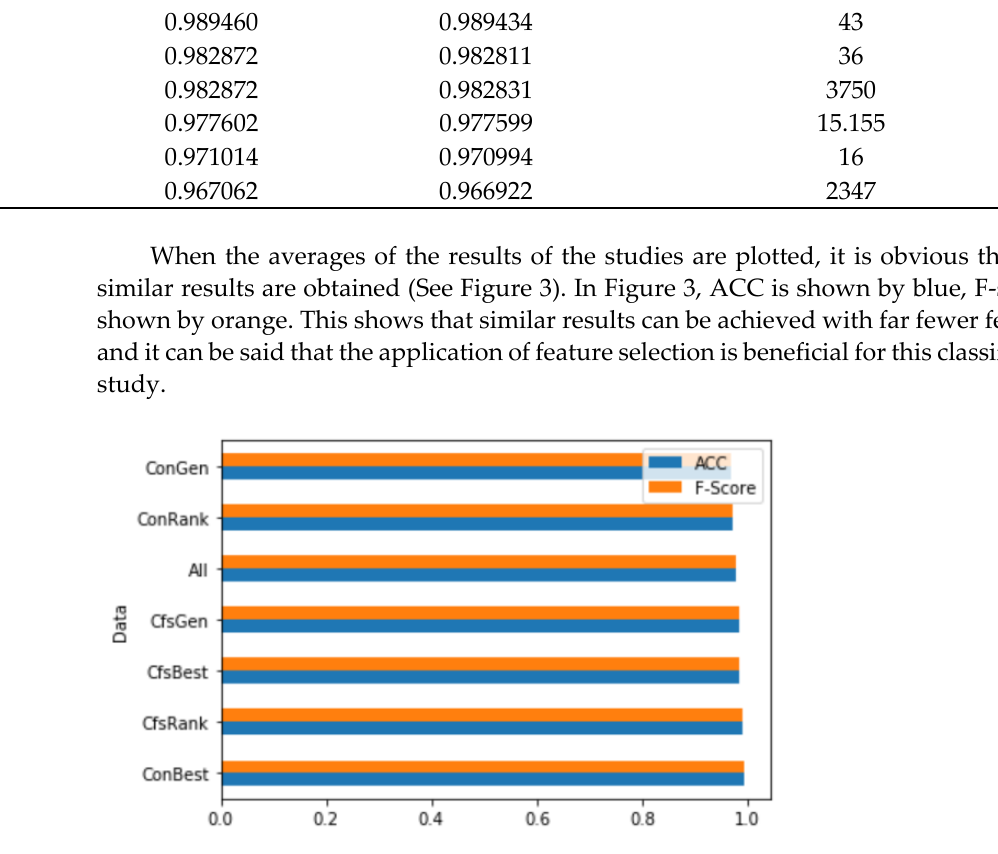
Figure 3. Average of Classification results